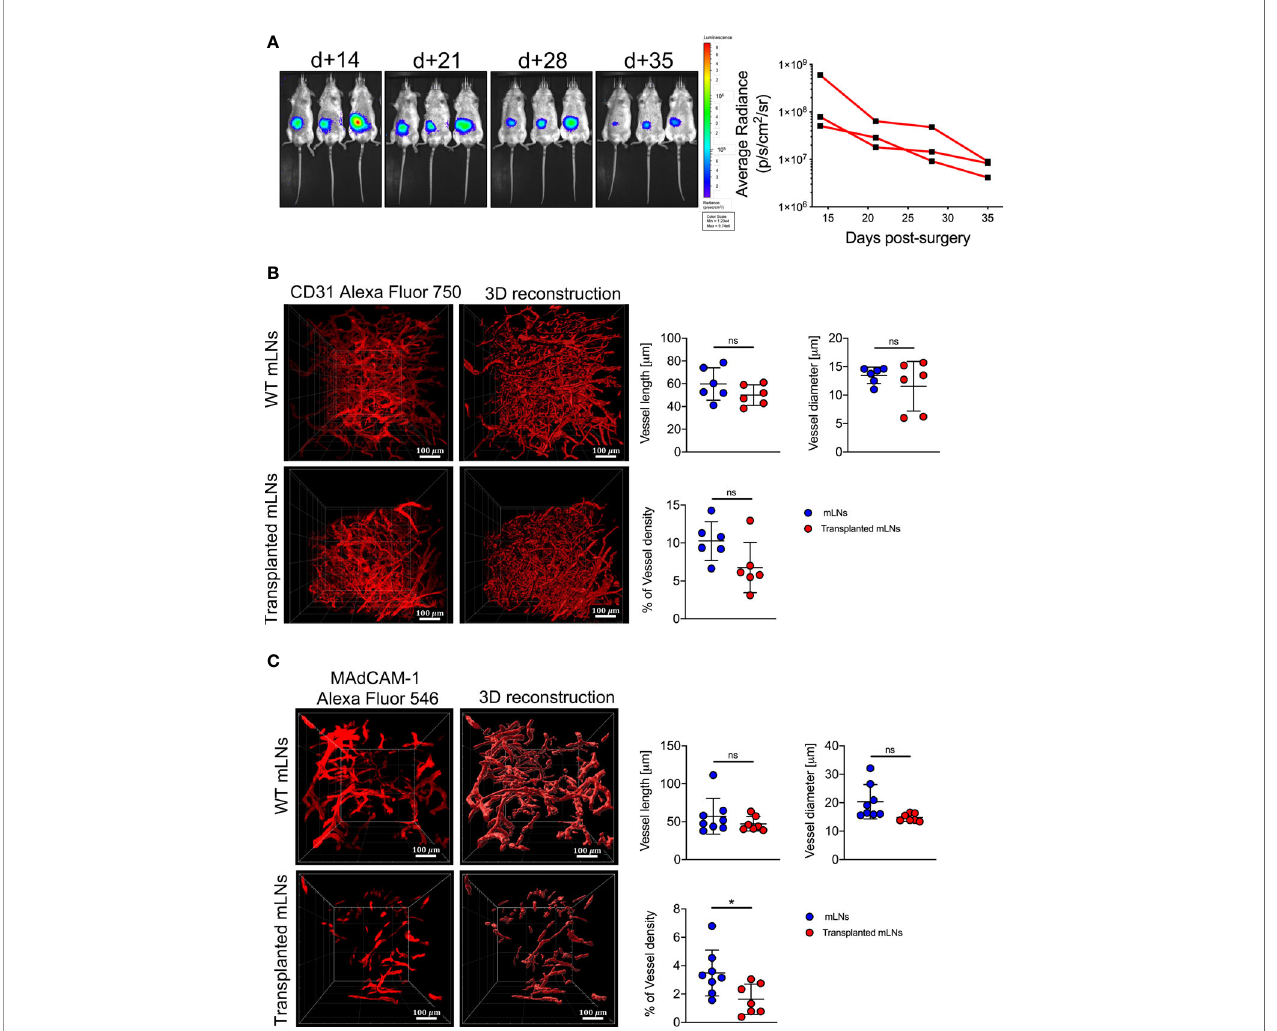
FIGURE 2 | Donor mLNs engrafted in the recipient mice after surgical transplantation. (A) Bioluminescence signals emitted from luc + mLNs from B6.L2G85 mice transplanted into a B6 albino recipient mouse and quanti fi cation (p/s/cm 2 /sr) of BLI signal from donor luc + mLNs. (B) Zoomed LSFM images of blood vessels staining with anti-CD31 antibody and 3D reconstruction (20x objective, scale bar = 100 m m) and quanti fi cation of blood vessel length, diameter and density were analyzed from reconstructed images on Imaris, 5 weeks after mLN transplantation. (C) Zoomed LSFM images of HEVs staining with anti-MAdCAM-1 antibody and 3D reconstruction (20x objective, scale bar = 100 m m) and quanti fi cation of HEVs vessel length, diameter and density were analyzed from reconstructed images on Imaris, 5 weeks after mLN transplantation. Each data point represents one mouse, data pooled from two experiments; unpaired non-parametric Mann-Whitney test, (Mean± SD); *p < 0.05; ns, not signi fi